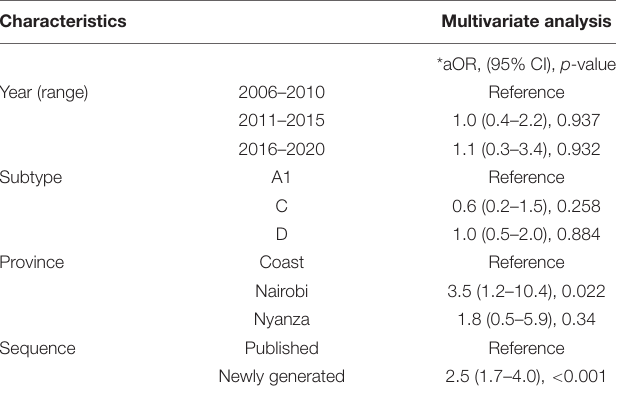
TABLE 3 | Factors associated with HIV-1 clustering among MSM with HIV-1 in Kenya. Characteristics